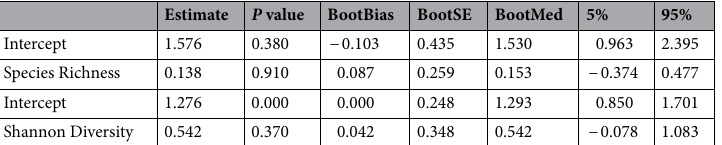
Table 1. Bootstrap regression testing the linear relationships of species richness and Shannon diversity index between agroforestry systems and adjacent natural